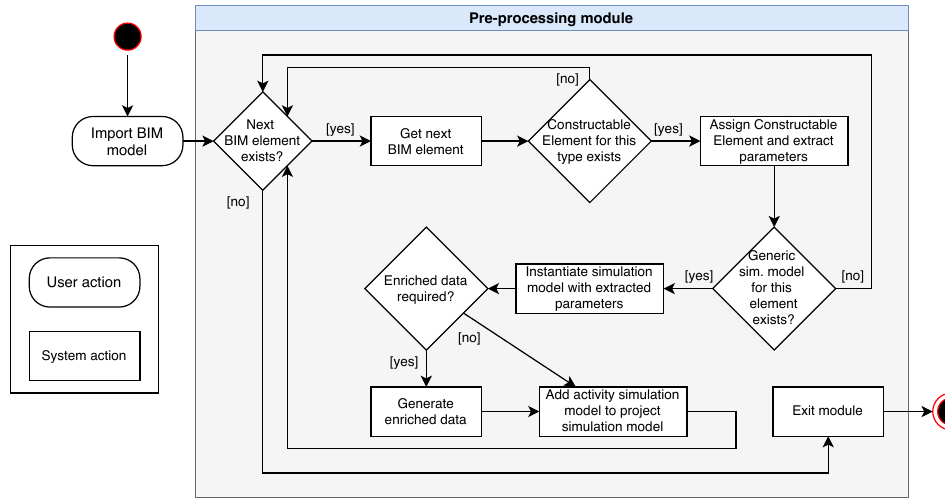
Figure 5. Flow diagram of the pre-processing